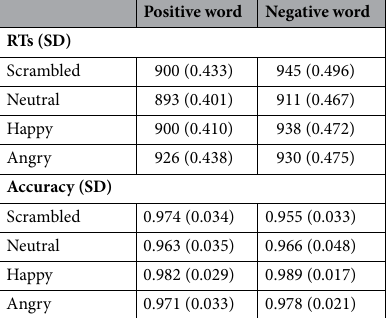
Table 1. Mean RTs (ms), accuracy (%) and standard deviations (SD) for the affective priming